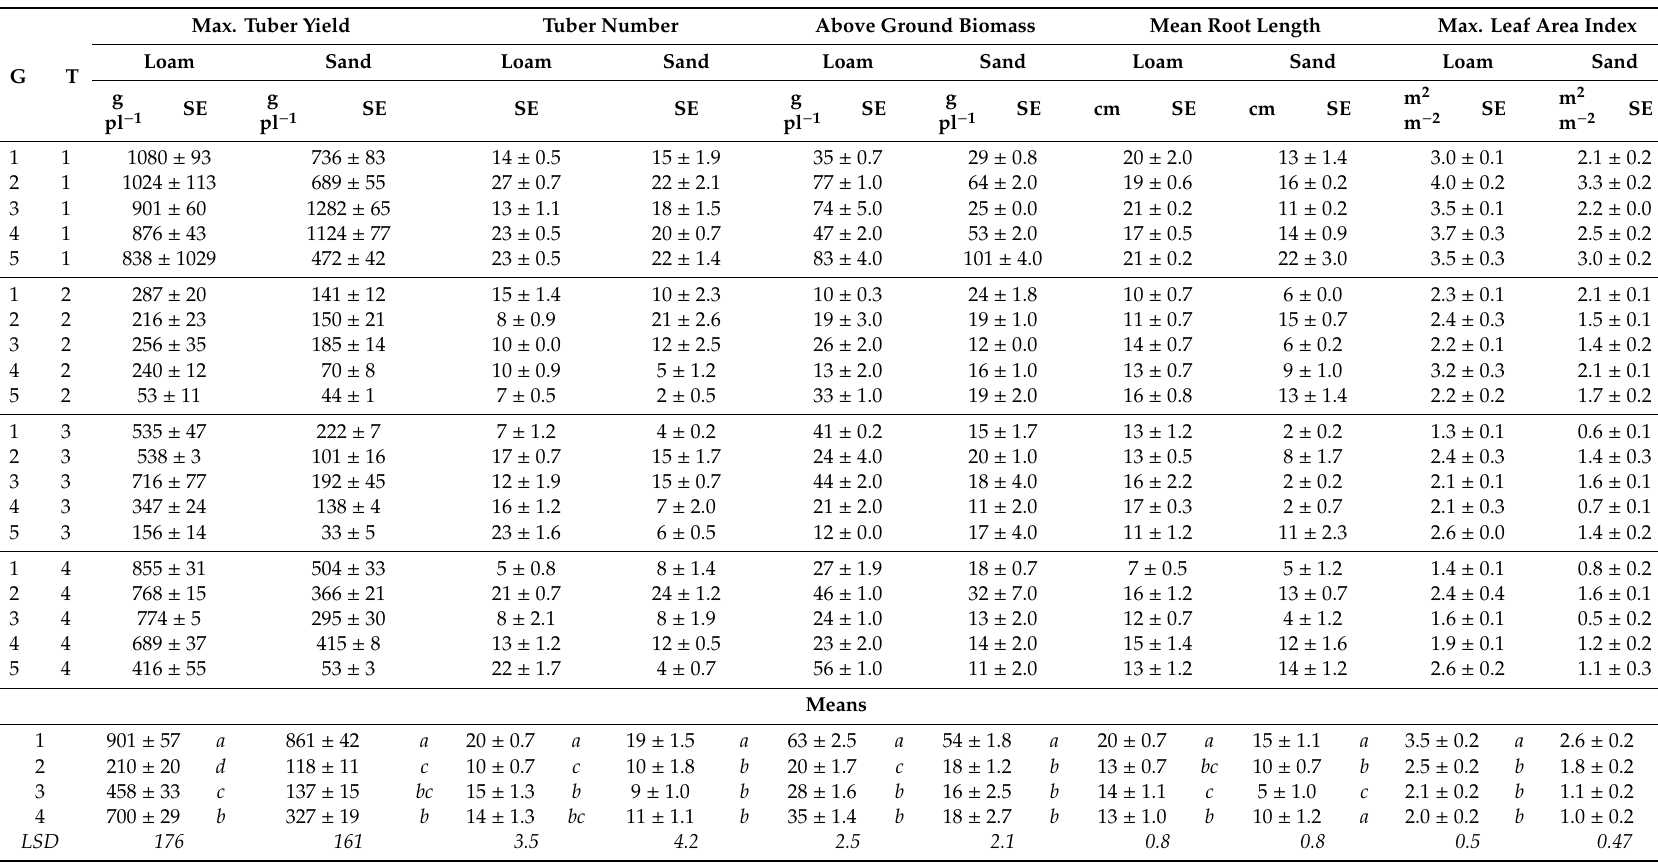
Table 4. Tuber yield, number of tubers per plant, above ground biomass, mean rooting depth, and maximum leaf area index for five genotypes subjected to four irrigation treatments on two contrasting soil types. Treatment 1 (T1) to Treatment 4 (T4), see Table 3; genotypes 1–5, see Appendix